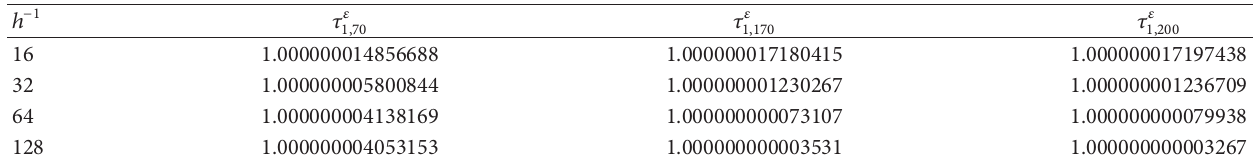
Table 6: The stress intensity factor 𝜏 𝜖 1,𝑛 for 𝑛 = 70, 170, 200 when 𝜀 = 5 × 10 −13 .